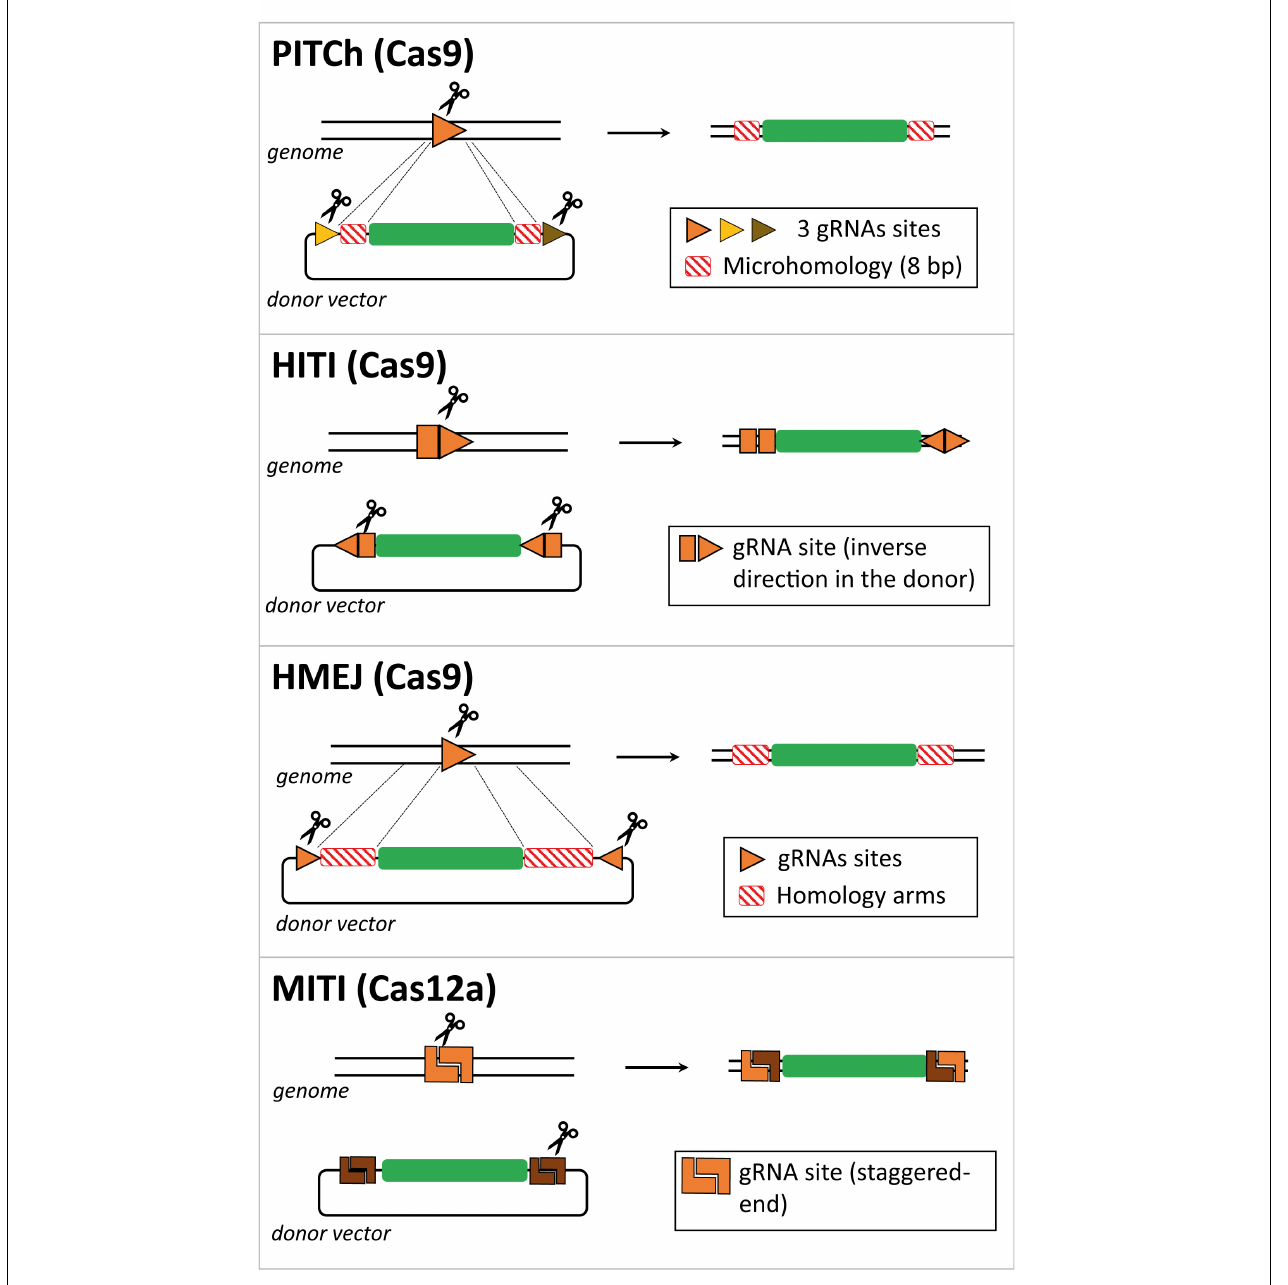
FIGURE 2 | Comparison between CRISPR/Cas-based strategies for targeted gene insertion in non-dividing cells. Schematic representation of several gene editing methodologies developed to direct targeted transgene integration in the genome independently of the HDR pathway, that is not active in non-dividing cells such as photoreceptors. The genomic locus and the donor DNA are cut by Cas effector proteins at gRNA target sites. Typically, the donor DNA contains two gRNA target sites to release the exogenous genetic information from the context of the delivery vector and aid its recombination with the target locus. These two gRNA target sites can have identical or dissimilar sequences and can be incorporated in a direct or inverted orientation. The Cas-induced DSB can generate microhomology regions between target and donor DNA, e.g., in the case of the PITCh and MITI methods. In the case of the HMEJ method, the lengths of the homology regions in the donor DNA are similar to those incorporated in HDR donors (i.e., ∼ 800 bp), yet they can be shortened to 24–48